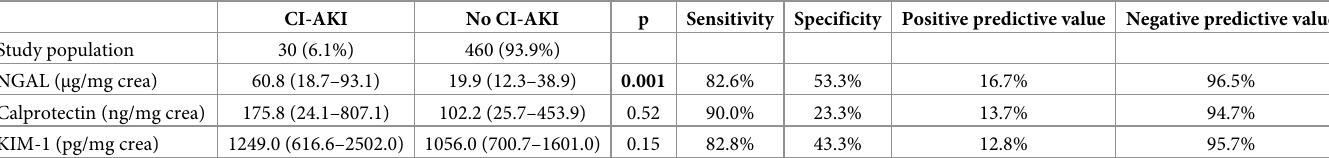
Neutrophil gelatinase-associated lipocalin (NGAL), kidney injury molecule-1 (KIM-1), and calprotectin in the prediction of contrast media induced acute kidney injury (CI-AKI). All urinary biomarkers are presented after normalization for urine creatinine concentration (crea). Numeric data is presented as median with interquartile range (in brackets). P < 0.05 is considered statistically